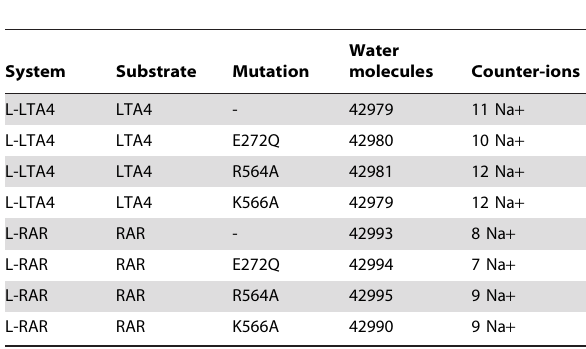
Table 1. The details of all systems subjected to MD